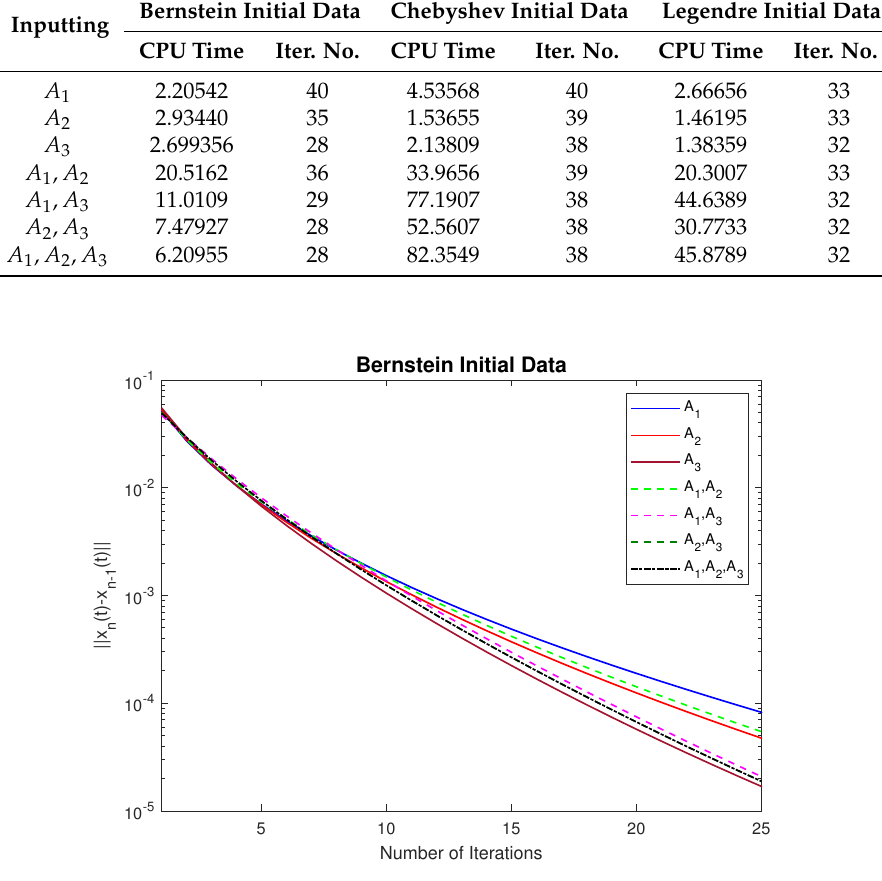
Figure 4. The error plotting (cid:107) x n ( t ) − x n − 1 ( t ) (cid:107) for choice 1 in Example 2.